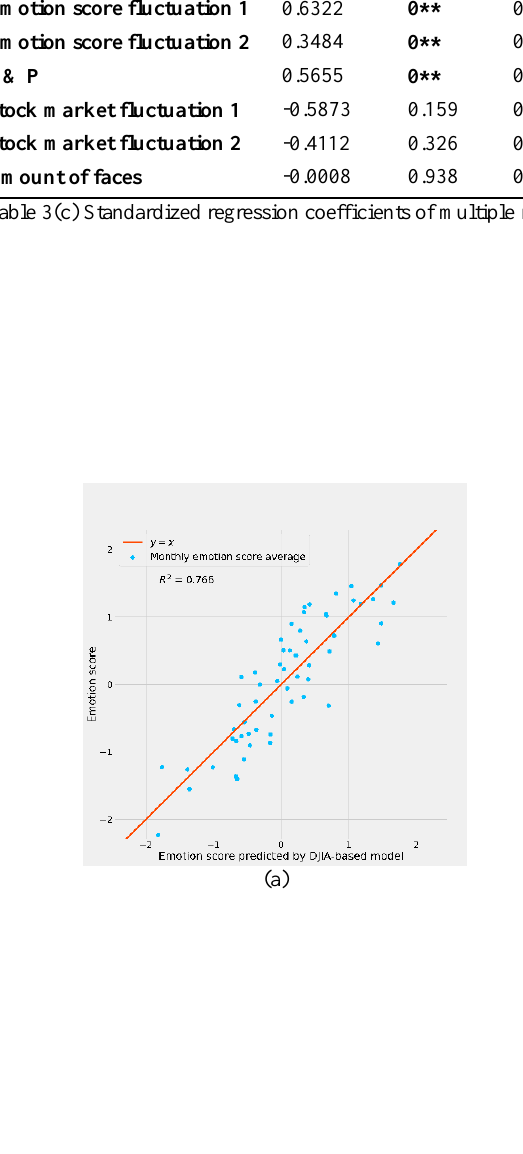
Table 3(b) Standardized regression coefficients of multiple regression models (NASDAQ)